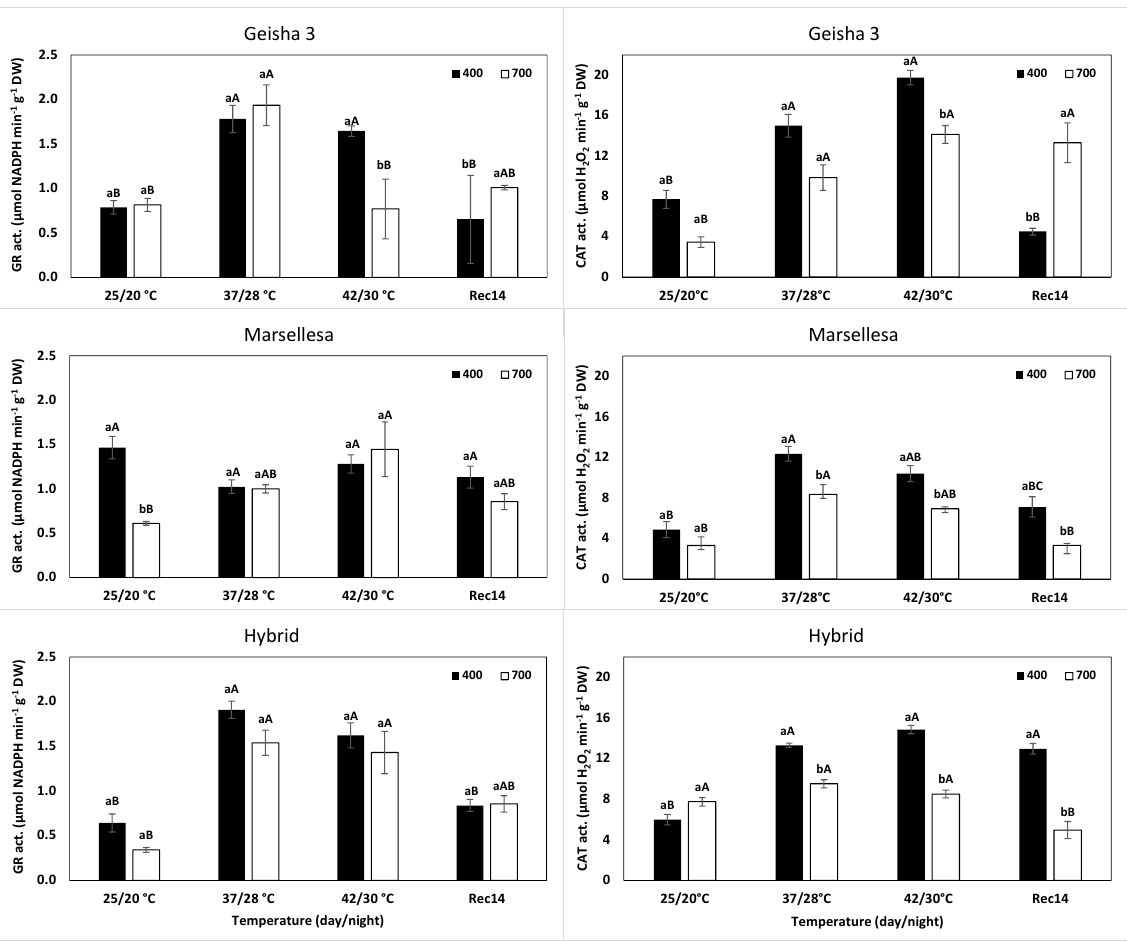
Figure 2. Changes in leaf cellular activities of glutathione reductase (GR) and catalase (CAT) enzymes in C. arabica cv. Geisha 3, cv. Marsellesa and their Hybrid (Geisha 3 × Marsellesa) plants grown under 400 or 700 µ LCO 2 L − 1 at control (25/20 ◦ C, day/night), submitted to supra-optimal temperatures (37/28 ◦ C, 42/30 ◦ C) and after 14 days of recovery (Rec14). For each enzyme, the mean values ± SE ( n = 3 plants) followed by different letters express significant differences between CO 2 treatments for each temperature, separately for each genotype (a, b), or between temperatures for the same CO 2 treatment (A, B, C), always separately for each genotype, where a > b and A > B >